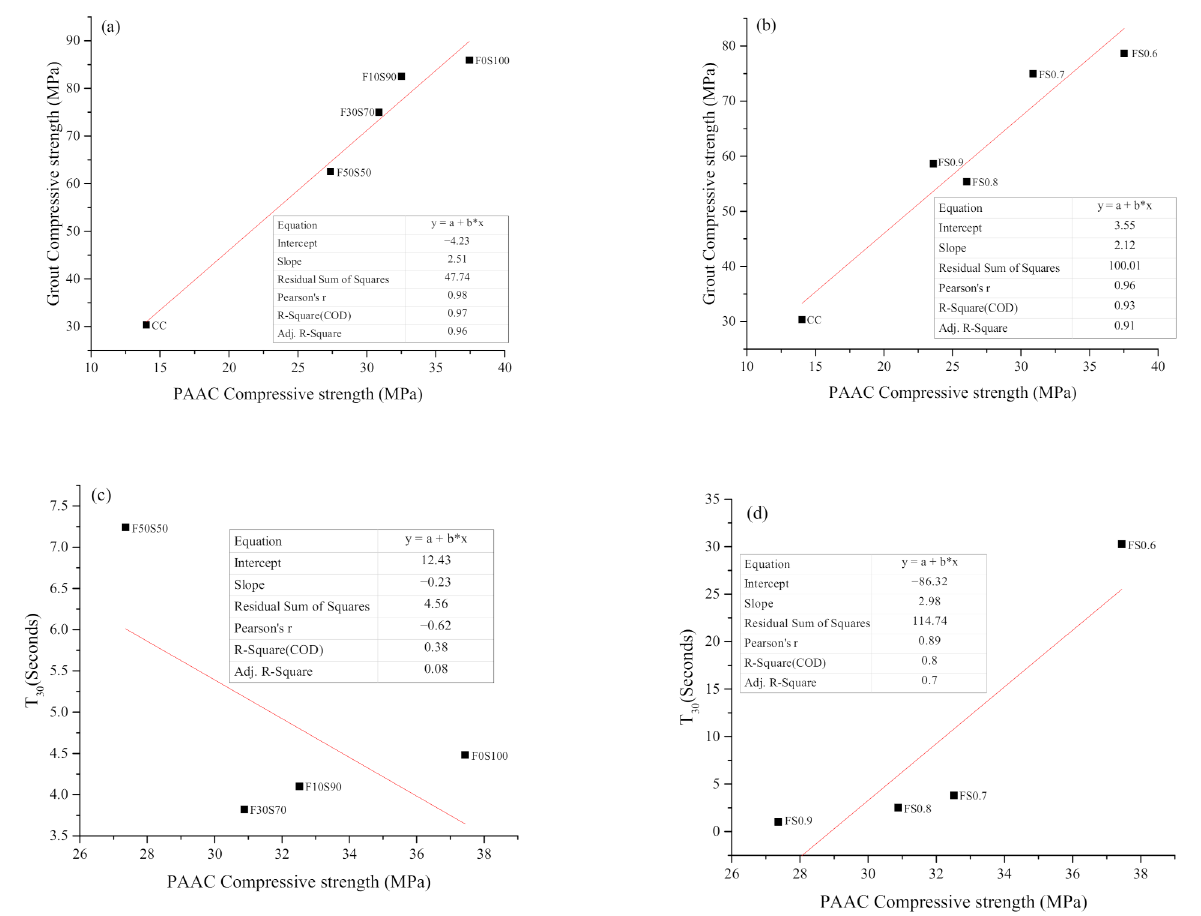
Figure 11. Correlation between grout and PAAC compressive strength: ( a ) Series 1 and ( b ) series 2, and, correlation between flowability of grout and PAAC compressive strength: ( c ) Series 1 and ( d ) series